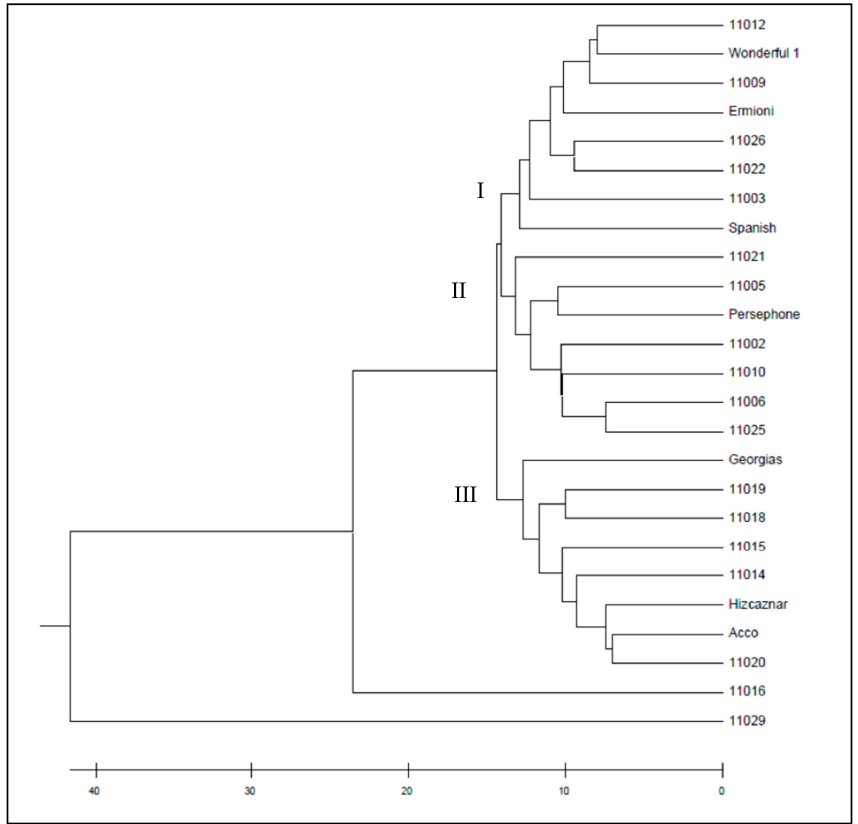
Figure 6. UPGMA dendrogram of the studied 26 pomegranate genotypes based on the combined genetic matrix of ISSR and SCoT markers. Agriculture 2021 , 11 , x FOR PEER REVIEW